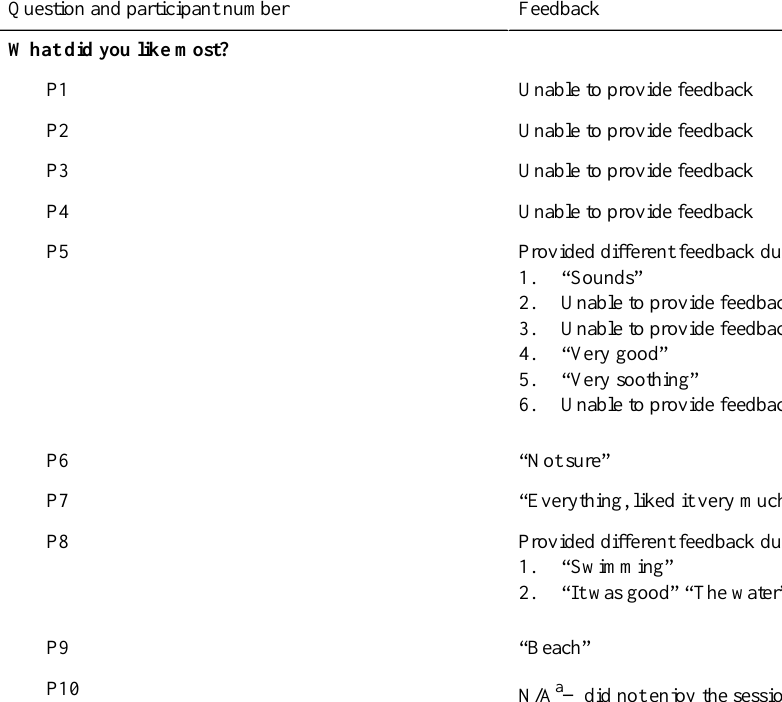
Table 4. Virtual reality content participant feedback